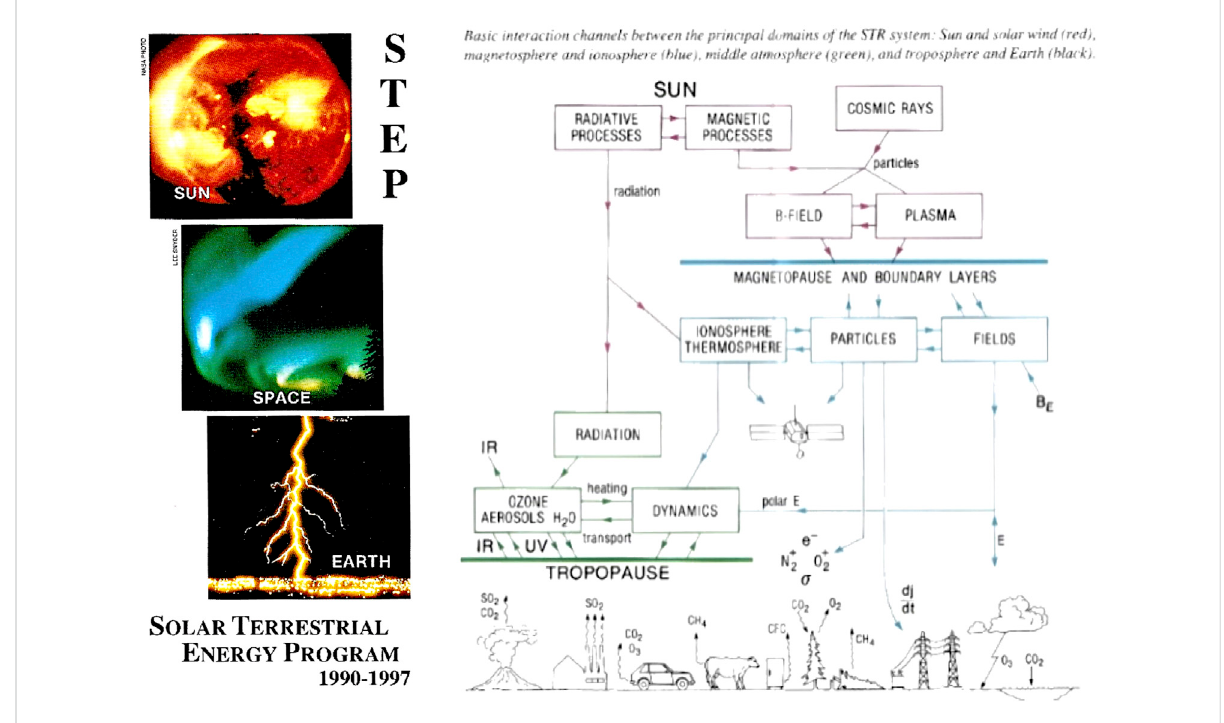
FIGURE 2 Brochure for theICSU international Solar-Terrestrial EnergyProgram 1990 – 1997 (STEP),showingrelevant domains and processes inthesolar- terrestrial domain, with a sketch of the perturbations determining the “ climate and weather in space ” and its coupling to the